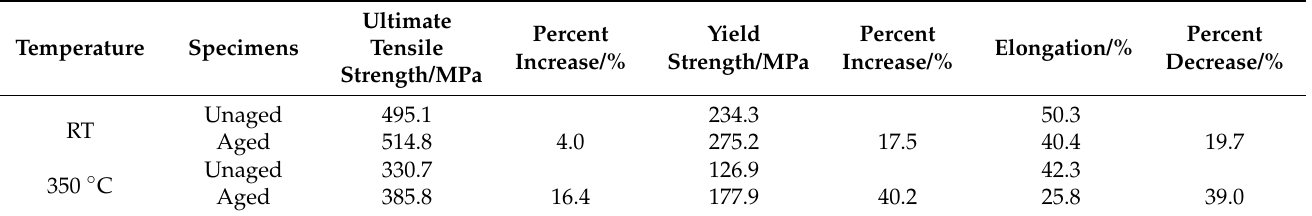
Figure 10. Engineering stress–strain curves of Z3CN20.09M specimens tested at 350 °C ( a ), the relationship between strength, elongation, and aging times ( b ), and engineering stress–strain curves of unaged and aged Z3CN20.09M specimens at room temperature and 350 °C ( c ). Table 2. Tensile properties of unaged and aged Z3CN20.09M specimens at room and moderate temperature for 200 h.